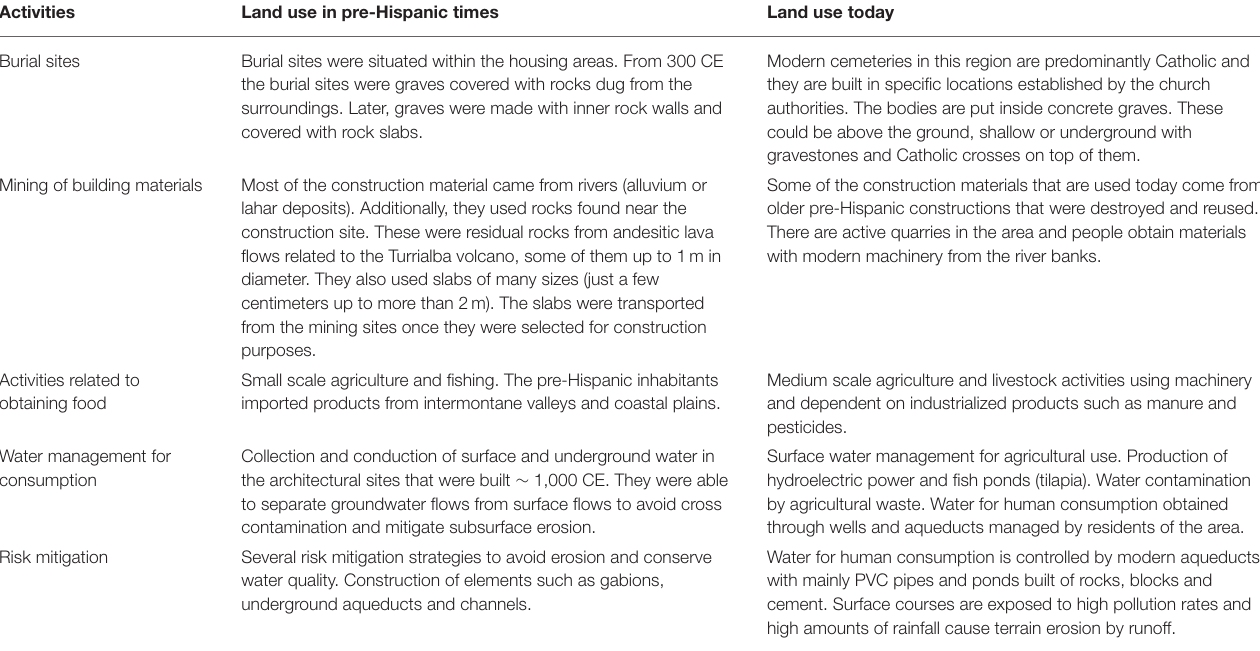
TABLE 1 | Comparison of past and modern land use in GNM and its surrounding area, based on our observations.